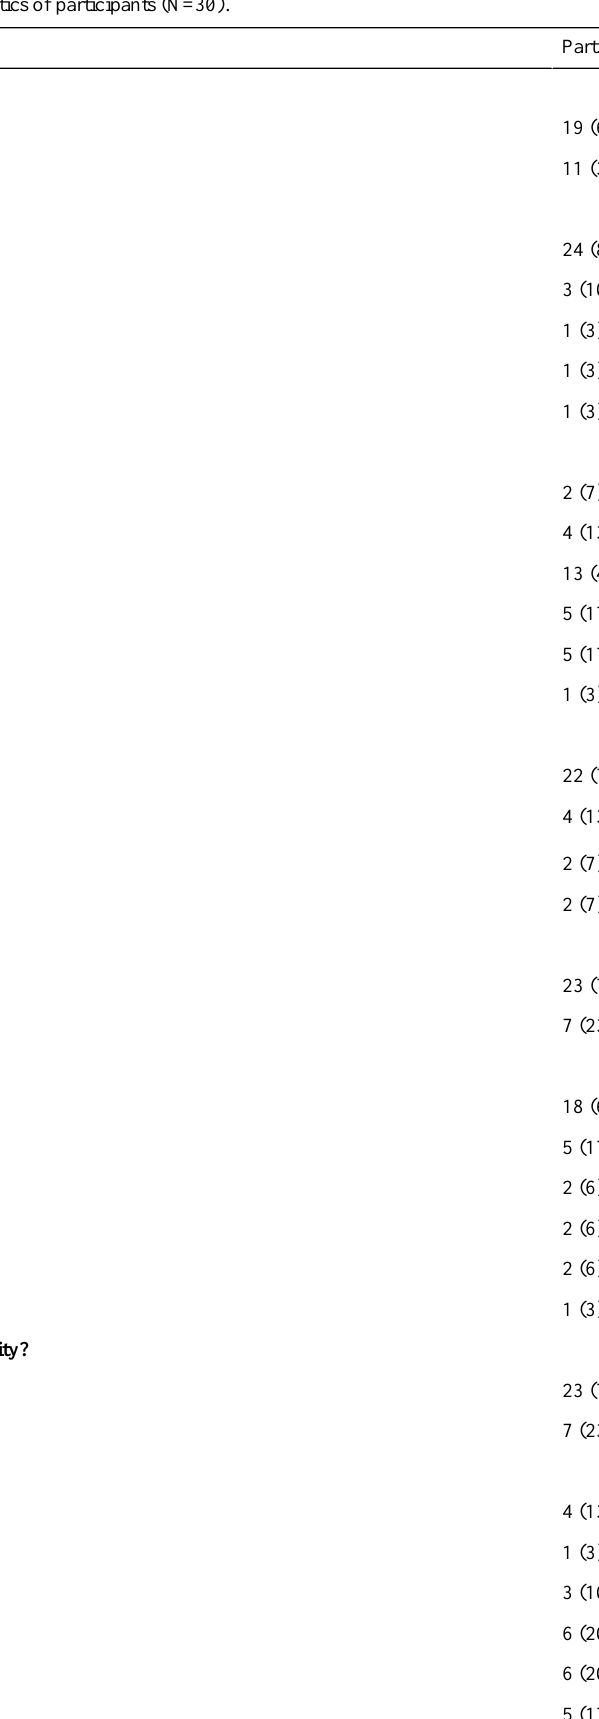
Table 1. Sociodemographic characteristics of participants